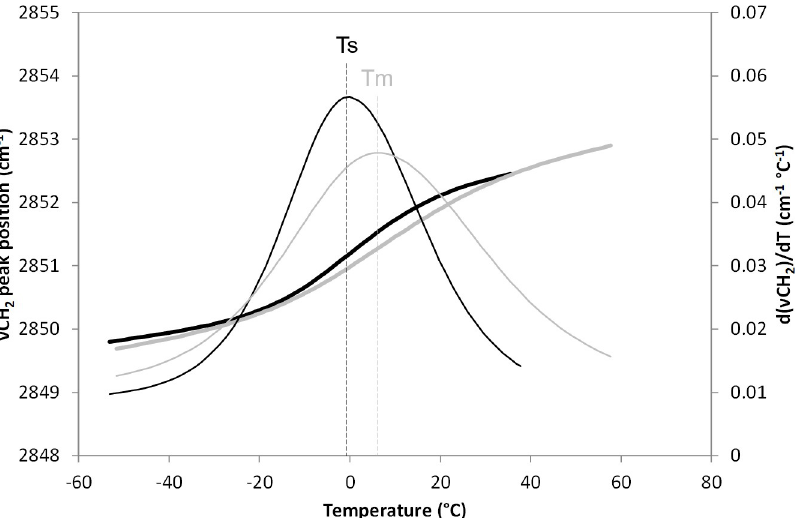
Fig 1. Membrane lipid phase transition of Jurkat cells identified by following the position of the symmetric CH 2 stretching vibration ( ν CH 2 ) of membrane fatty acids chains by Fourier transform infrared spectroscopy. Measurements were carried out during cooling from 37˚C to -50˚C (thick black) and warming to 60˚C (thick grey) at rates of 2˚C min -1 . Derivatives of these curves were calculated (thin lines) and their maxima were taken as the membrane lipid phase transitions: solidification on cooling (thin black, Ts), observed at -1.0˚C ± 0.8˚C and melting on warming (thin grey, Tm), observed at 5.8˚C ± 0.2˚C (n = 3).